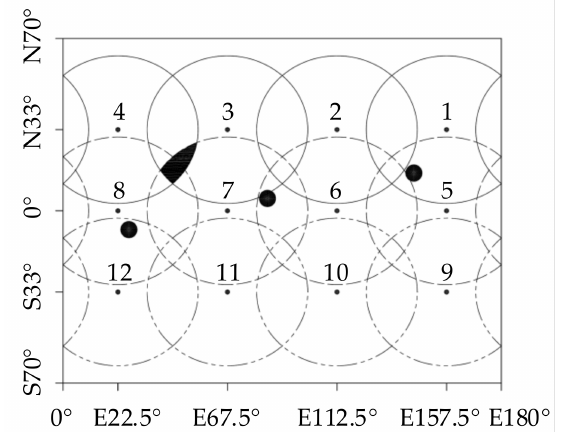
Figure 10. Distribution of the detectable range of each group of